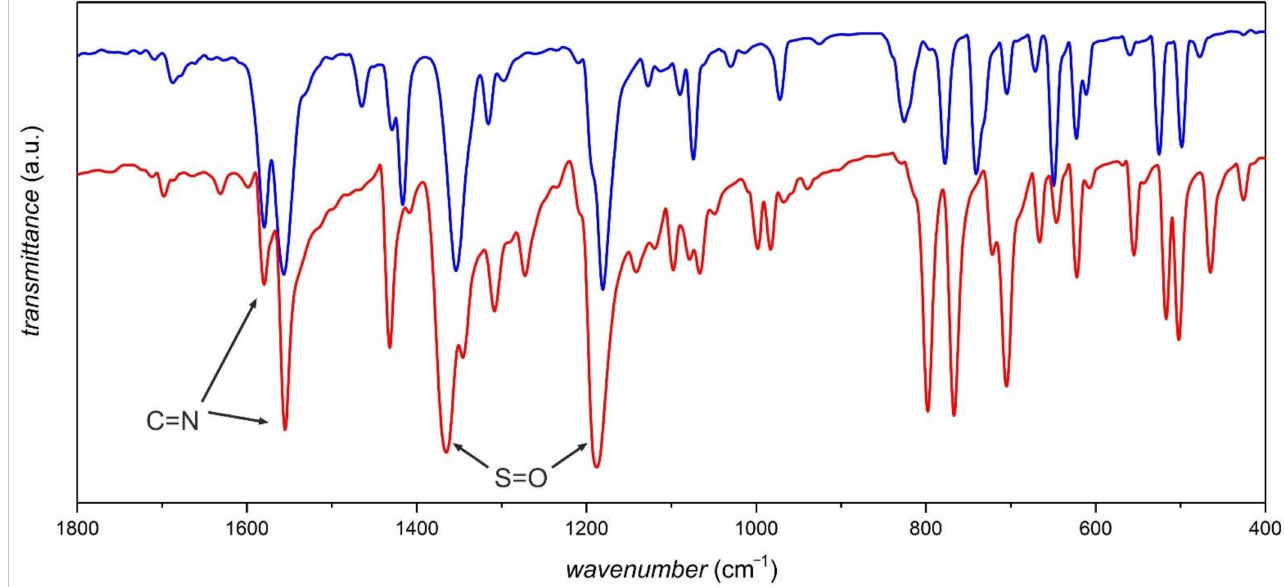
Figure 3. Fingerprint regions of the IR spectra of two dioxothiadiazole derivatives: [1,2,5]thiadiazolo[3,4- f][4,7]phenanthroline 2,2-dioxide (ref. [43]; blue line) and [1,2,5]thiadiazolo[3,4-f][1,10]phenanthroline 2,2-dioxide (ref. [44]; red line) with the C=N and S=O stretching vibration bands